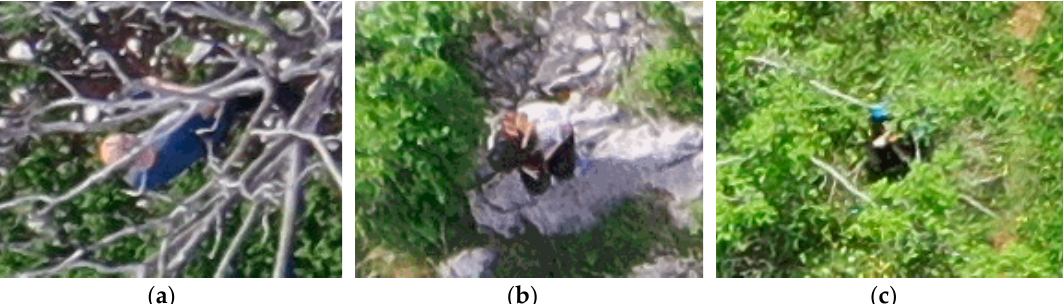
Figure 11. False negative examples for the ScoreMap to ROI algorithm: ( a ) The person is in occlusion, ( b ) The person is dressed in grey clothes and black pants and it is very difficult to distinguish him or her from the environment, ( c ) The person is in occlusion, and only parts of his clothing and arms are clearly visible.